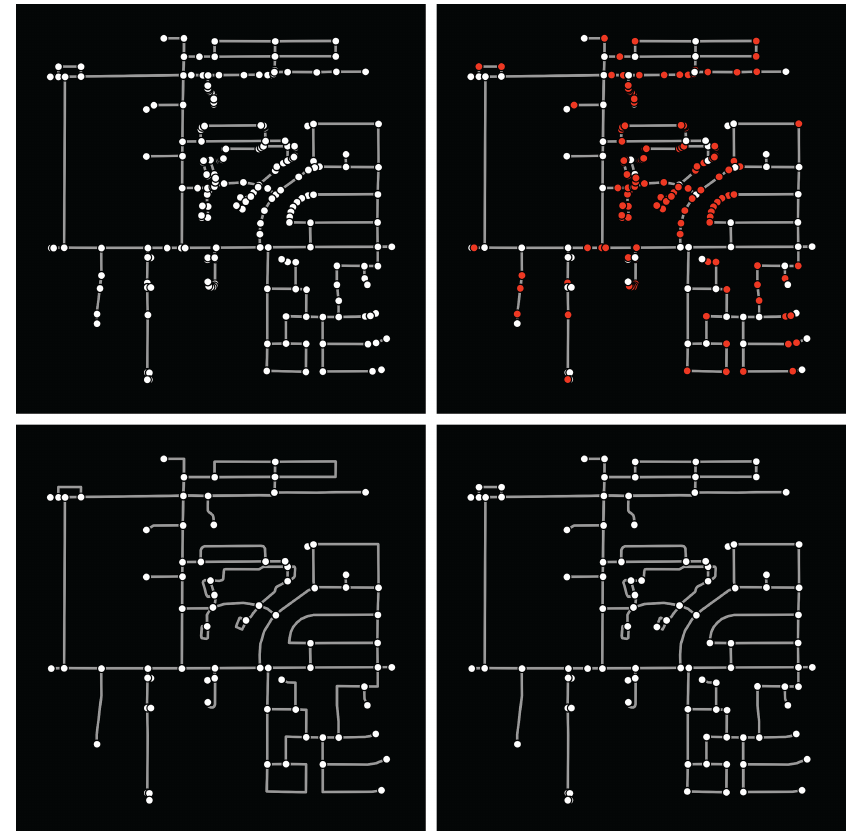
Figure 2. OSMnx street network topology cleaning. ( Top-left ) original graph (nodes in white, edges in gray). ( Top-right ) original graph (strict-mode pseudo-nodes highlighted in red). ( Bottom-left ) graph simplified in strict mode. ( Bottom-right ) graph simplified in non-strict